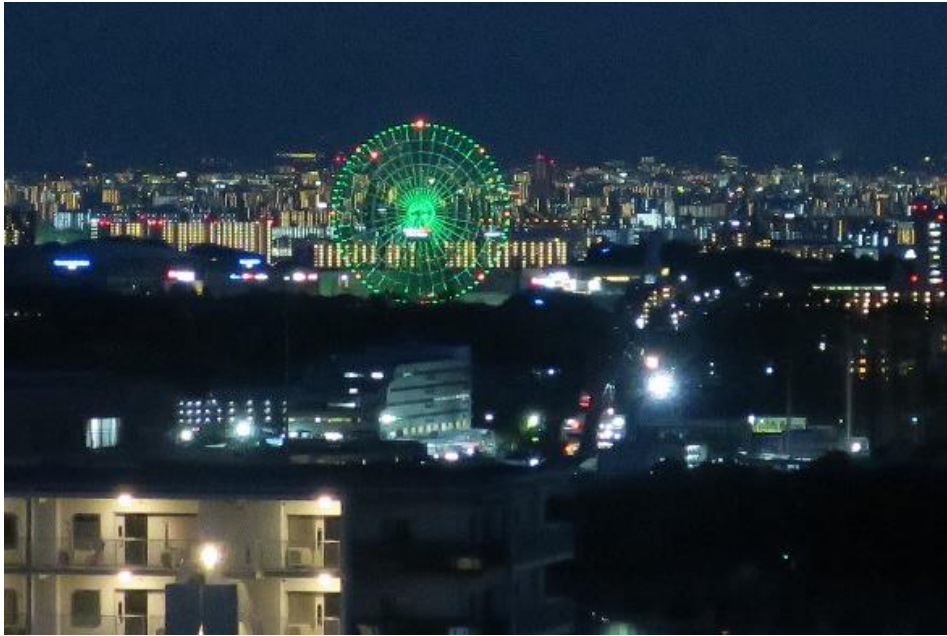
Figure 4: The light of the Ferris wheel near the Expo Park in northern Osaka informed the residents of the status of the coronavirus outbreak through the color of the neon signs: red, yellow, and green (Osaka, Japan May 2020; Photo courtesy of